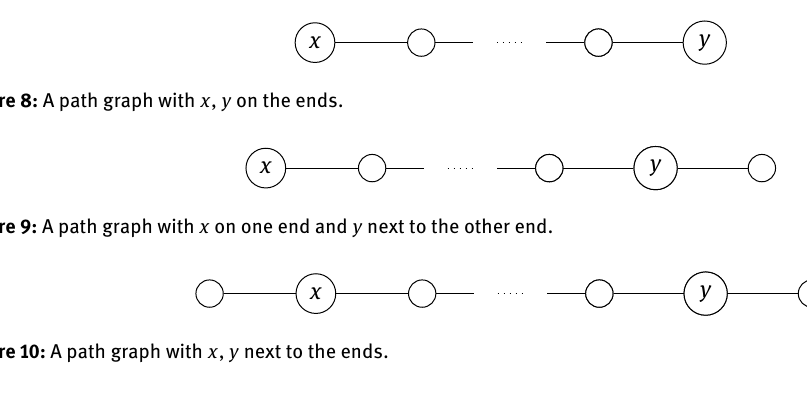
Figure 10: A path graph with x , y next to the